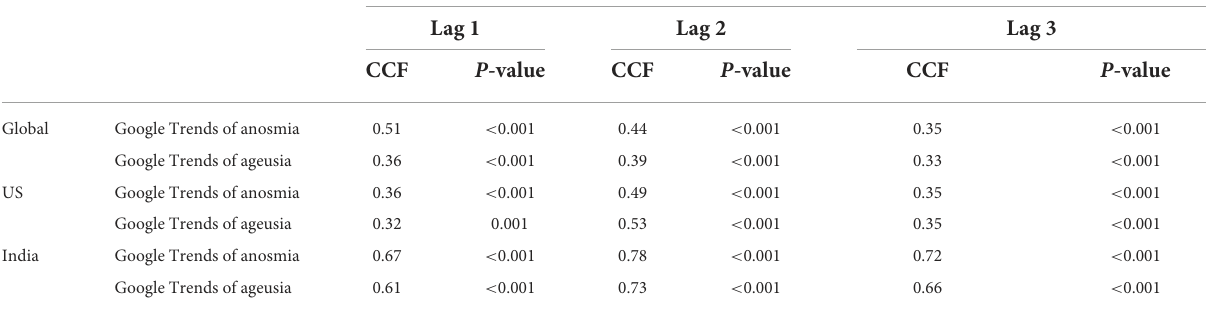
TABLE 1 Results of cross-correlation function